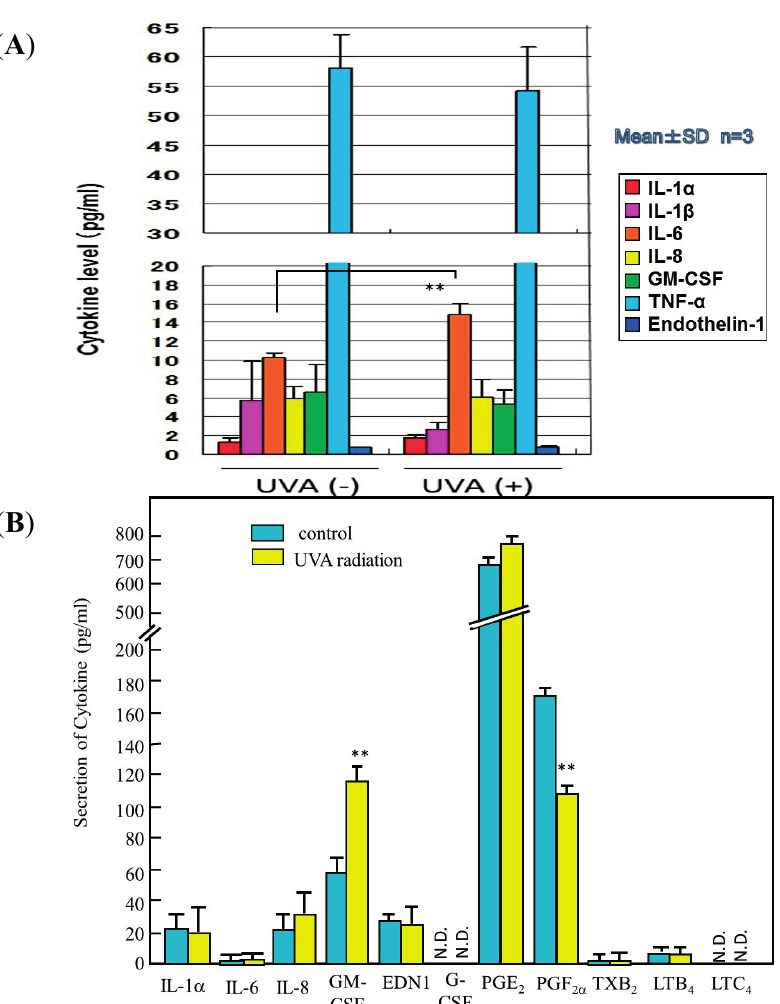
Figure 11. Secretion levels of cytokines (pg/mL) in the medium of cultured human dermal fibroblasts ( A ) and in the medium of cultured human primary keratinocytes ( B ) 72 h after UVA irradiation with 10 J/cm 2 . EDN1: endothelin-1, G-CSF: granulocyte-colony stimulatory factor. ** p < 0.01 vs. UVA- or control, N.D.: not